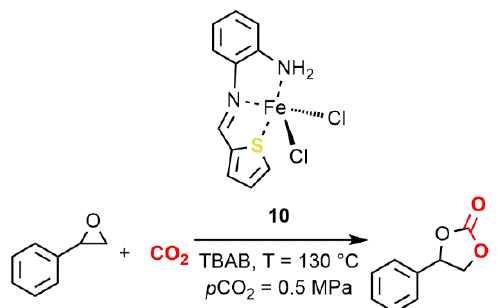
Figure 12. Coupling of styrene oxide (SO) and CO 2 promoted by the iron(II) thiophenaldimine complex 10 [66].